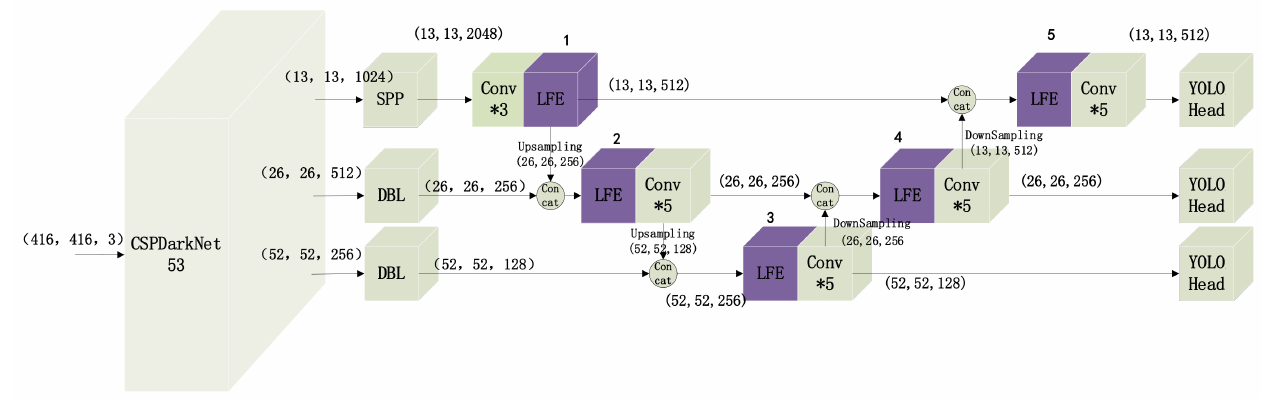
Figure 3. Improved YOLOv4. Scheme I: Insert a position feature extraction module in positions 1–5, respectively. Scheme II: Positions 1–5 are all inserted into the LFE block. DBL: DarkNetConv2D + Batch Normalization + Mish; SPP: Spatial Pyramid Pooling; Conv: Convolutional Layer; Concat: